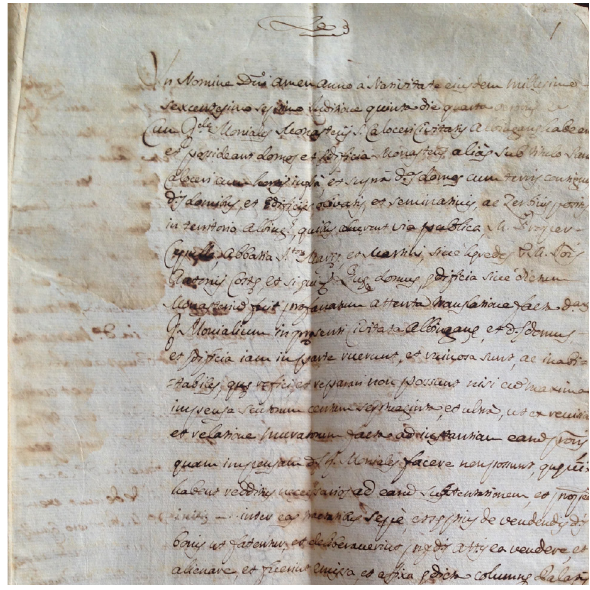
Stanga)Figure 8. First section of the sale agreement (Archivio Istituto Internazionale di Studi Liguri, Fondo